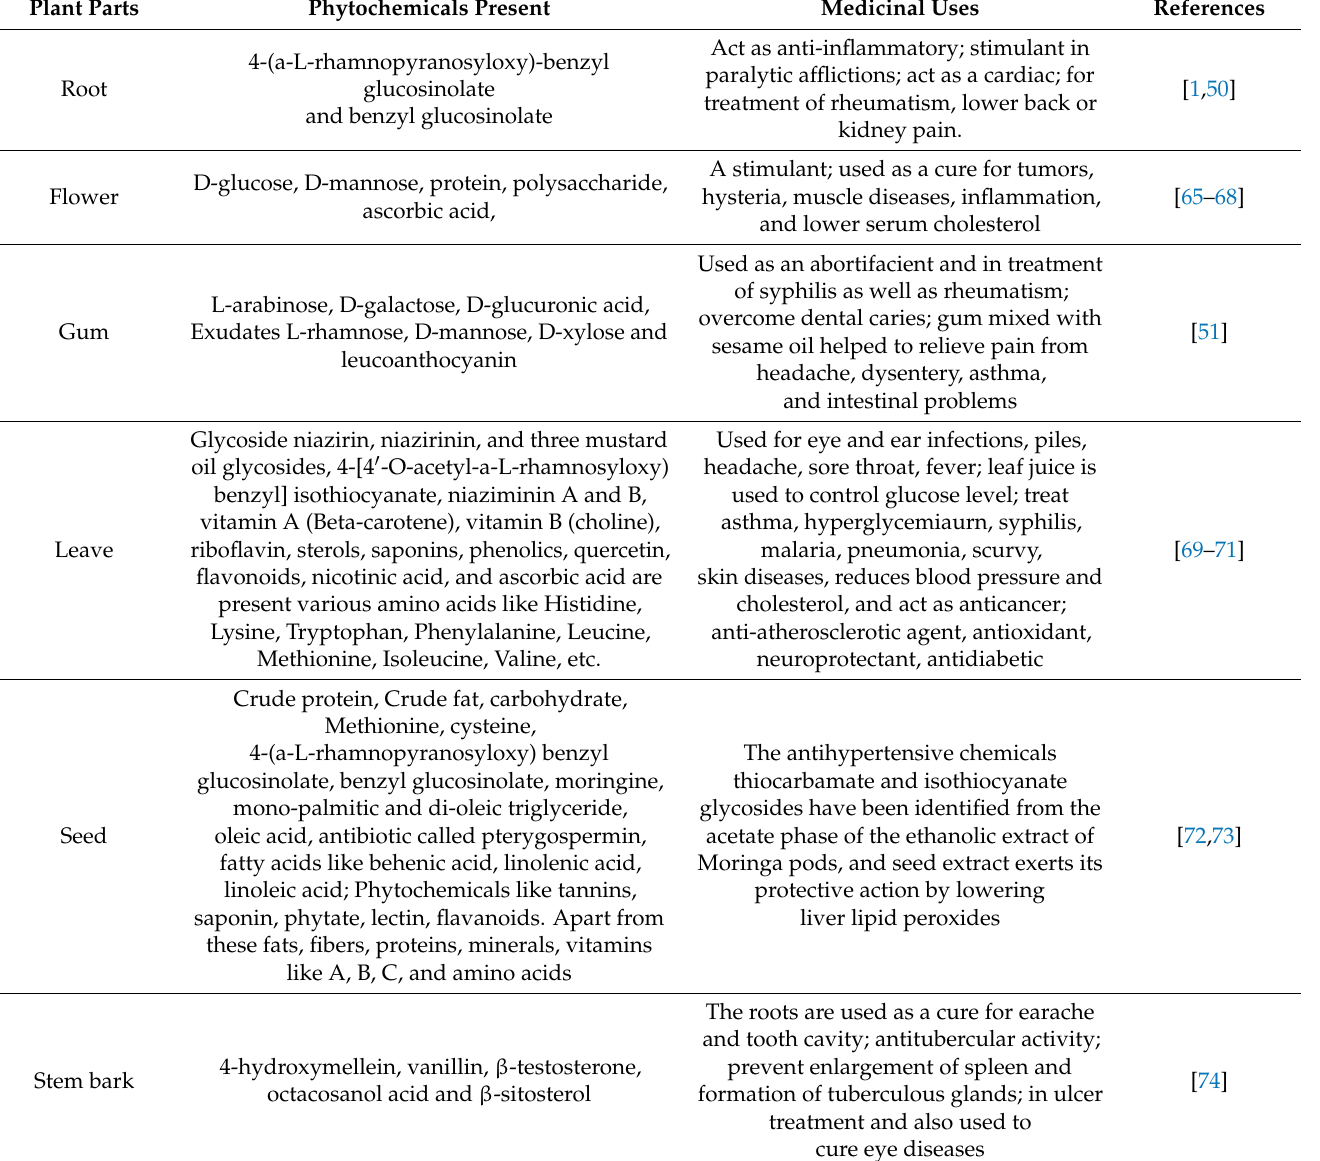
Table 4. M. oleifera phytochemicals and their medical